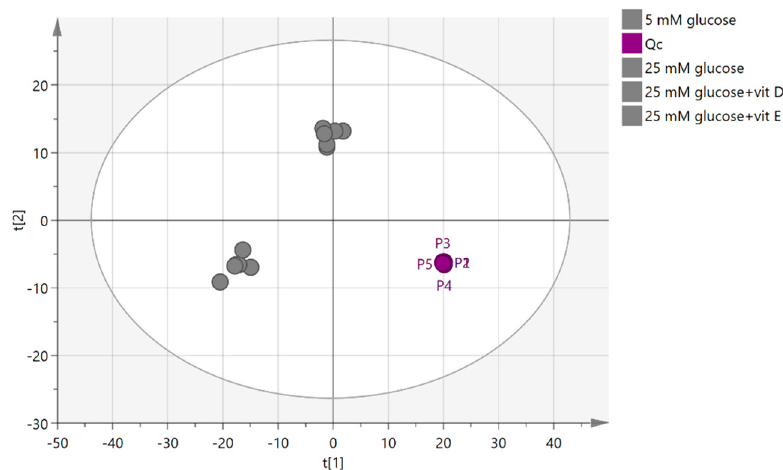
Figure 6. Principal components analysis (PCA) score plot for quality control (QC) (pooled) cell extract samples of (PASMCs). P1, P2, P3, P4, and P5 represent the quality control sample runs frequently throughout the experiment.